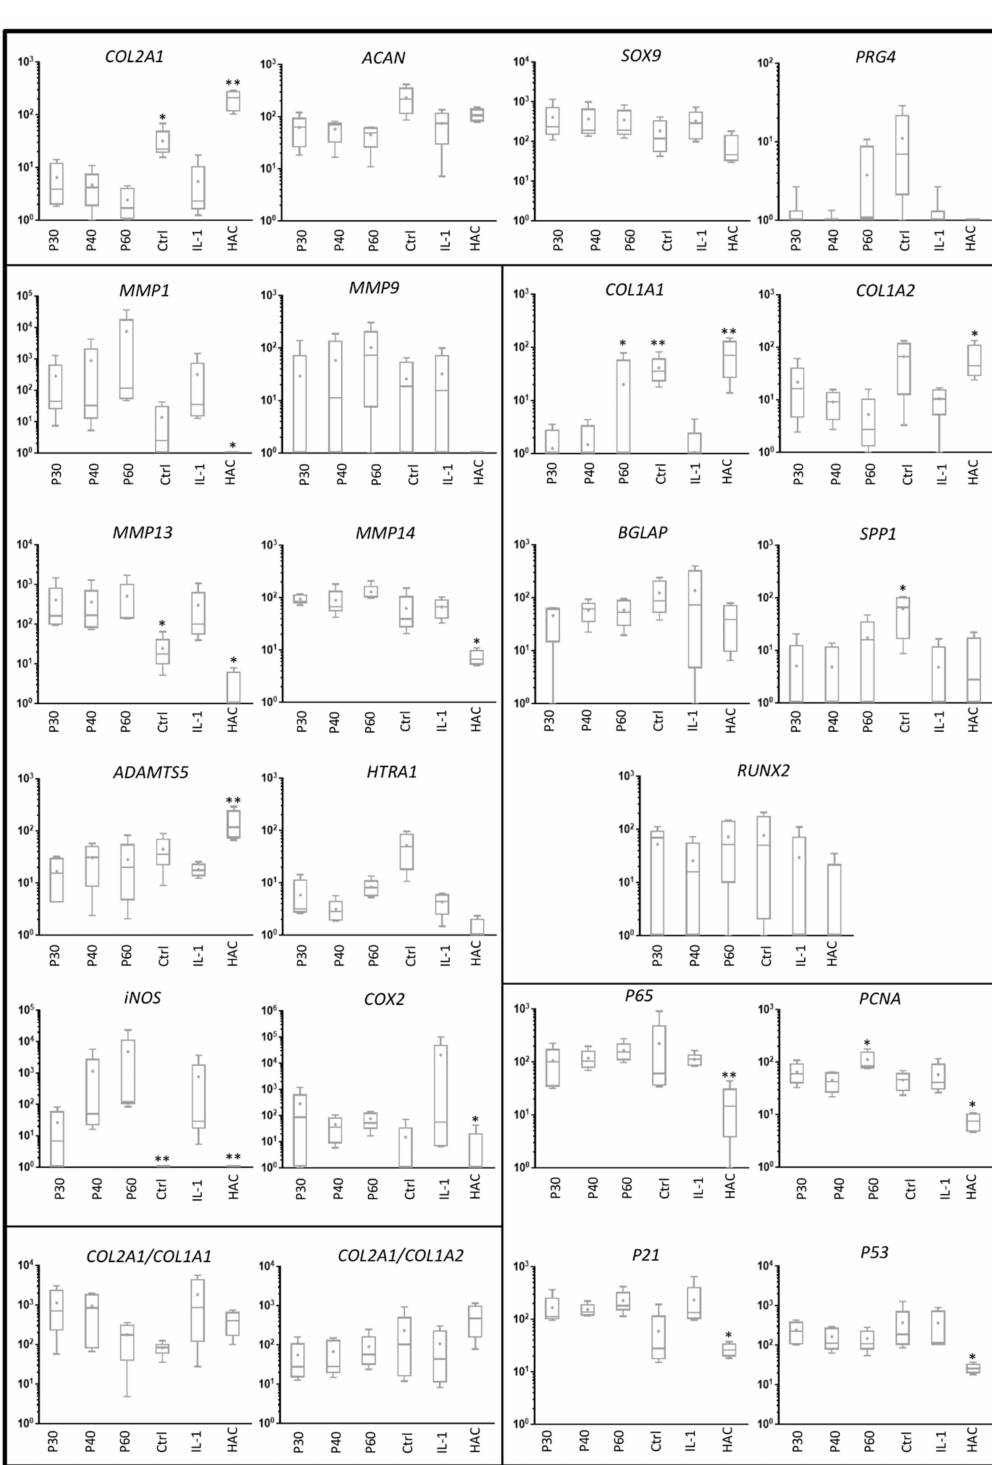
Figure 8. Effect of high concentrations of Promerim ® 30, 40 and 60 on gene expression profile in human articular chondro- cytes. Human articular chondrocytes were grown in type I/III collagen sponges at (P2) for 7 days in hypoxia treated with or without IL-1 β (10 ng/mL) in the presence of 50 µ g/mL Promerim ® 30, 40 or 60 at (P30, P40, P60). Results are summarized in box plots ( n = 5) showing the mean (cross) and the median (line) of relative mRNA expression estimated using RT-qPCR and normalized to the β -ACTIN and PPIA reference genes. The COL2A1 : COL1A1 and COL2A1 : COL1A2 ratios are given. HAC: mRNA obtained from human articular chondrocytes at P0 were used as controls, Ctrl: chondrocytes were grown in type I/III collagen sponges in the absence of IL-1 and Promerim ® . Statistical analyses were performed using the two-way ANOVA followed by Dunnett’s multiple comparison post-test (* p < 0.05; ** p < 0.01) compared with the IL-1